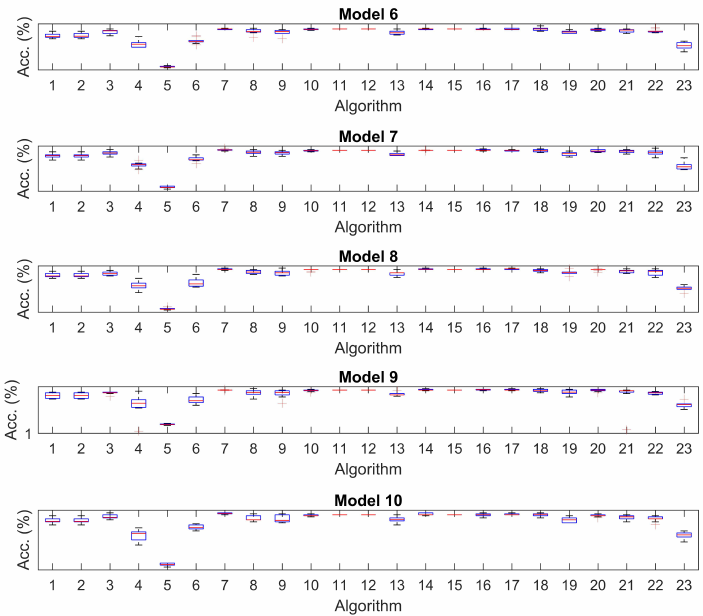
Figure 5. Numerical simulation Assumption 2. Accuracy of various models after permutations in the numerical values of the mapping. The 23 algorithms are represented in the x -axis, and the accuracy is shown in the y -axis.